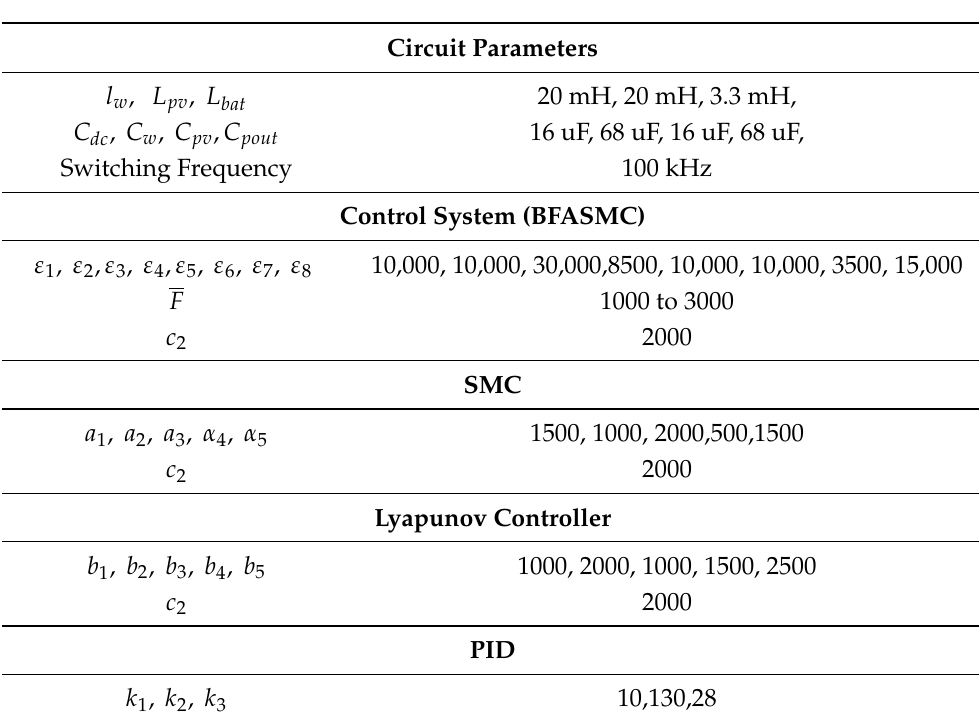
Table 4. Simulation